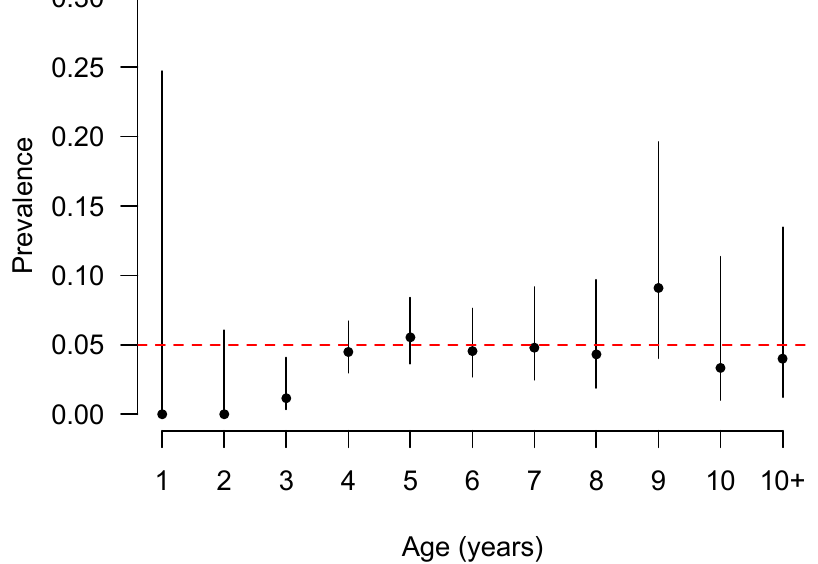
Figure 4. Age stratified seroprevalences of seropositivity to Q fever in dairy cattle from 5 of 6 Regions of Tanzania. N.B. Mbeya data was dropped as there were no positives in this Region.